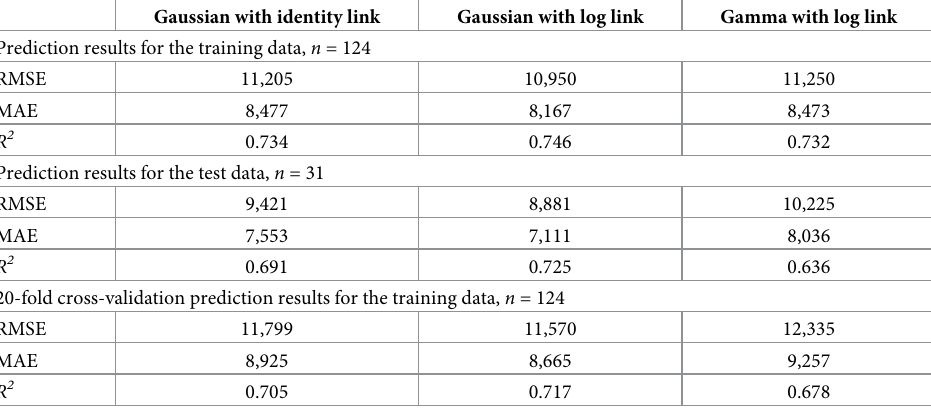
Table 5. Machine learning model prediction results for American Samoa longline fishery tip cost models. Gaussian with identity link Gaussian with log link Gamma with log link Prediction results for the training data, n = 124